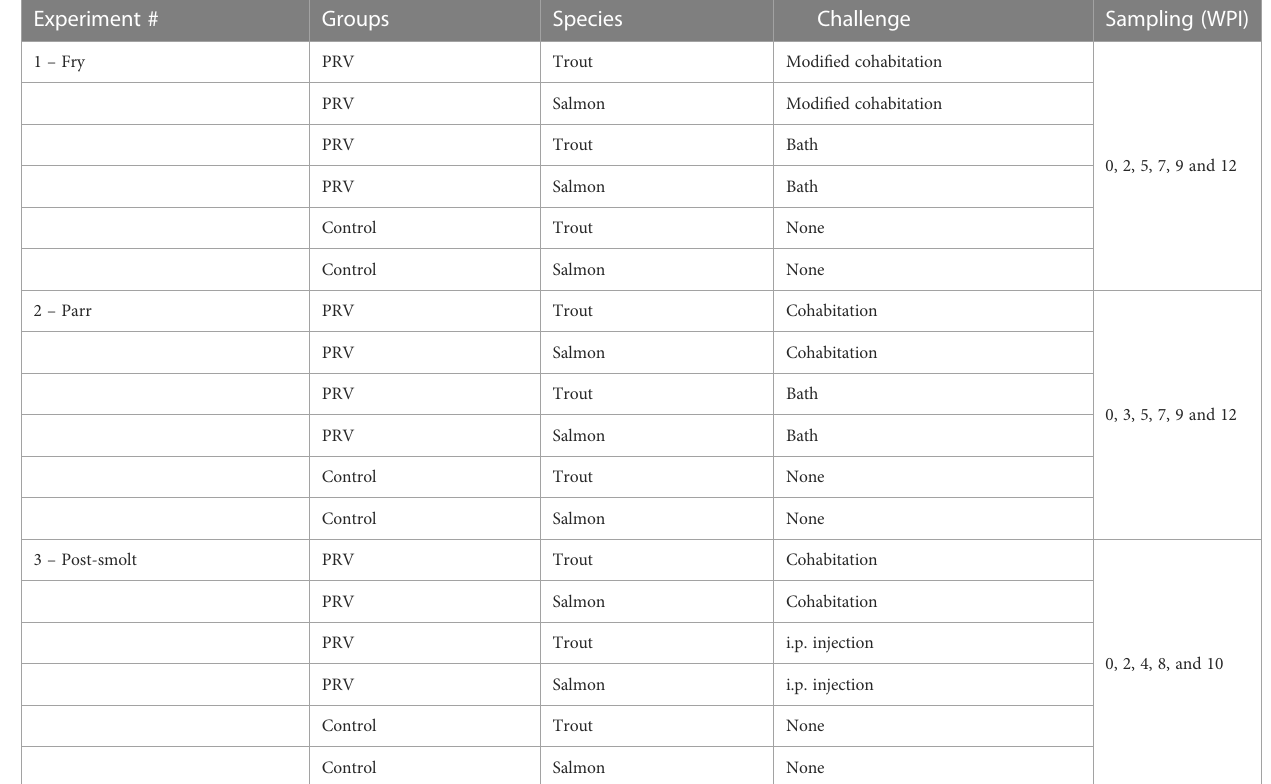
TABLE 1 Overview of experimental